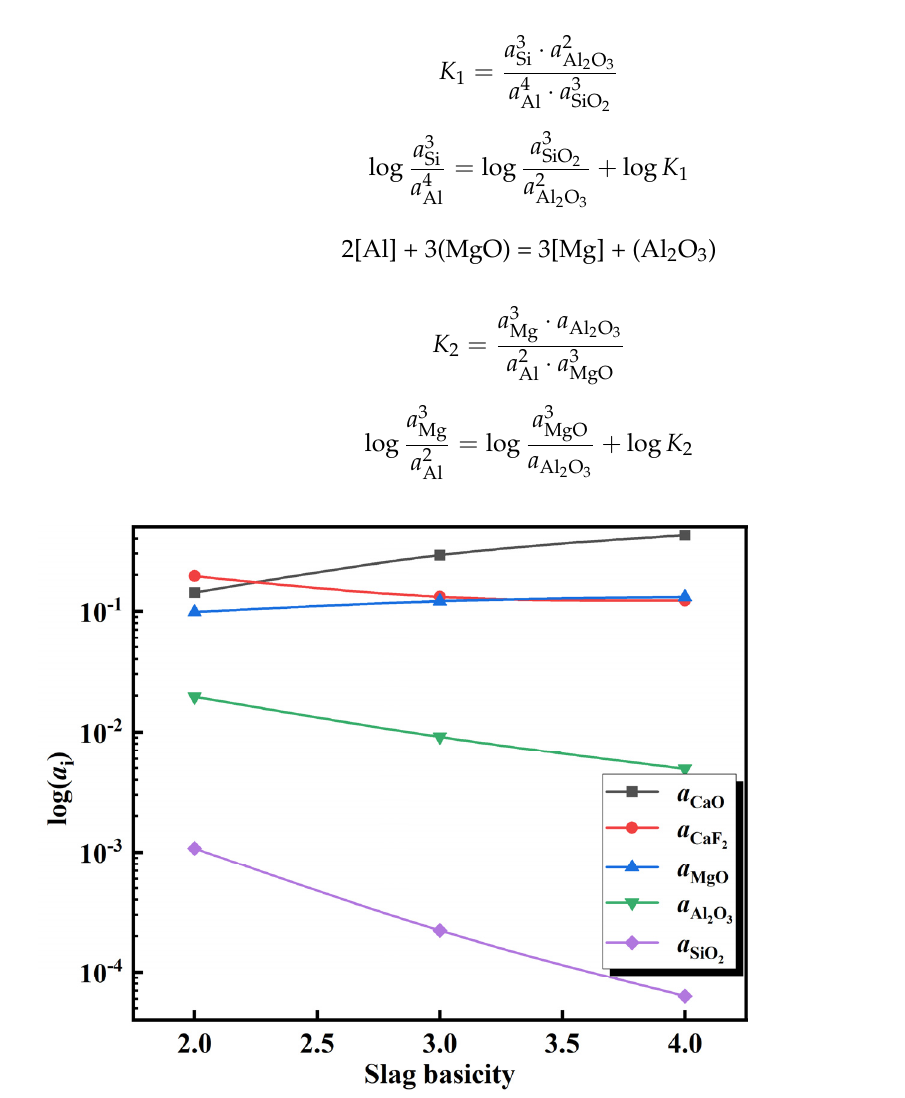
Figure 11. Relationship of activity with slag basicity.